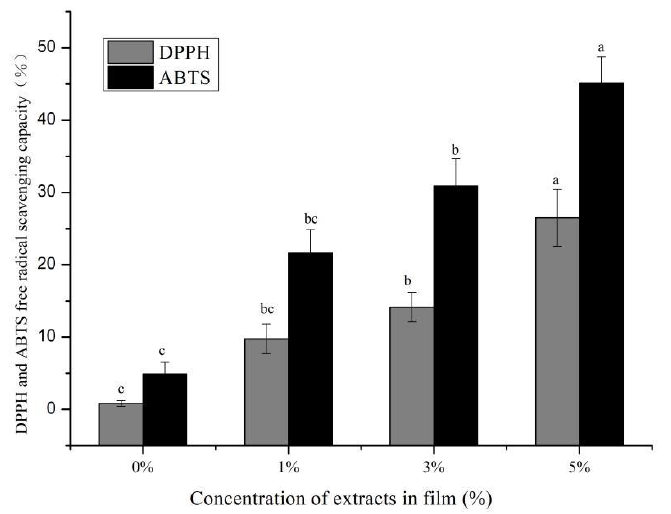
Figure 6. Scavenging activities of the CS/ κ C complex films on DPPH and ABTS radicals. a–c Values are given as mean ± standard deviation. Different letters in the same line indicate significantly different ( p < 0.05).